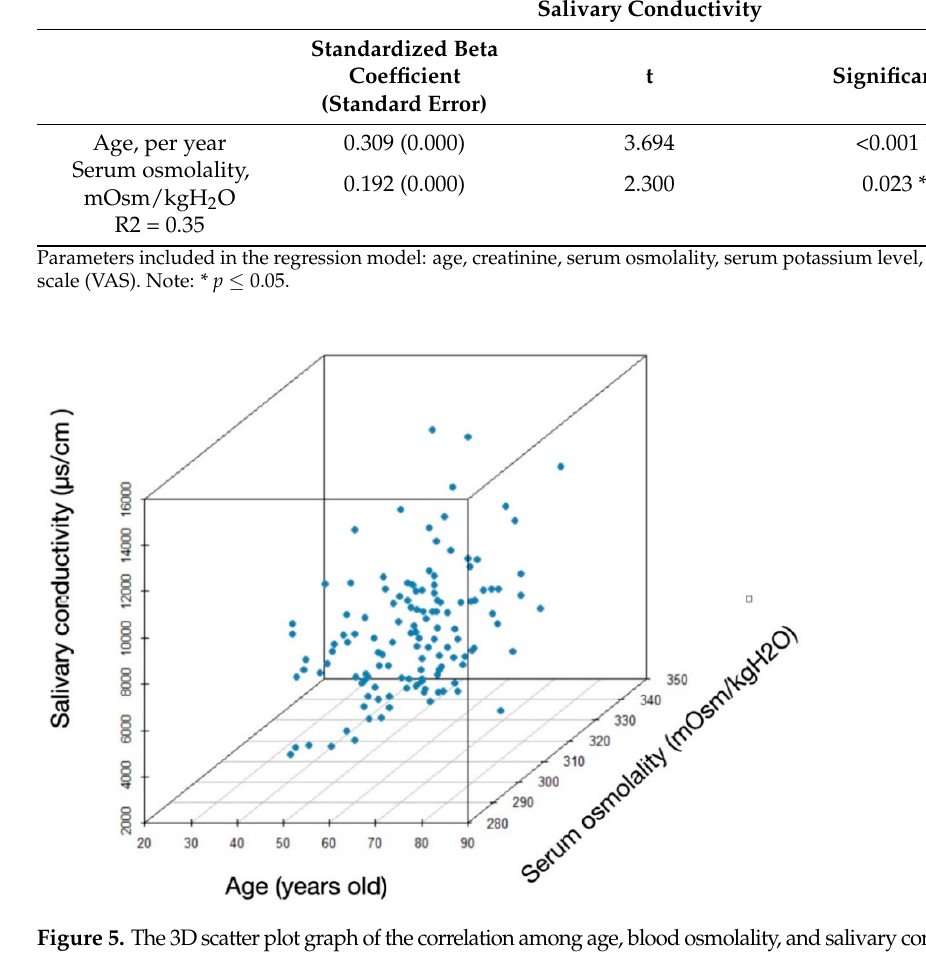
Figure 5. The 3D scatter plot graph of the correlation among age, blood osmolality, and salivary